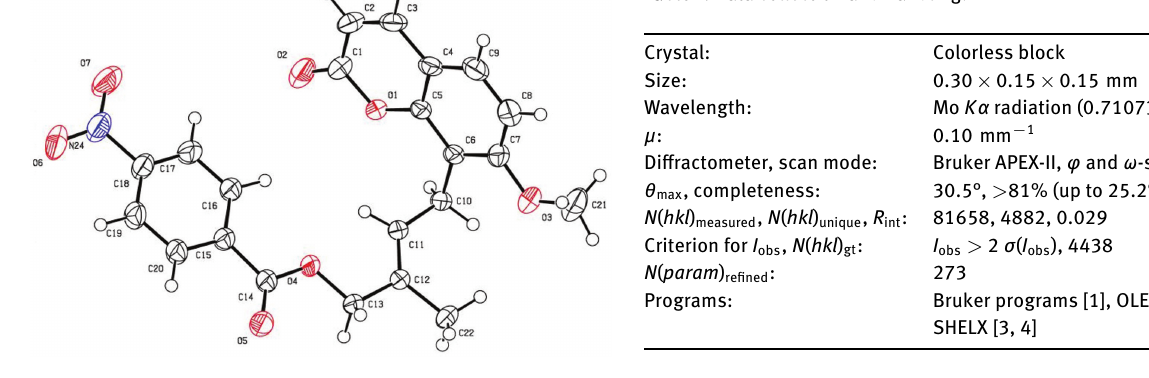
Table 1: Data collection and handling.